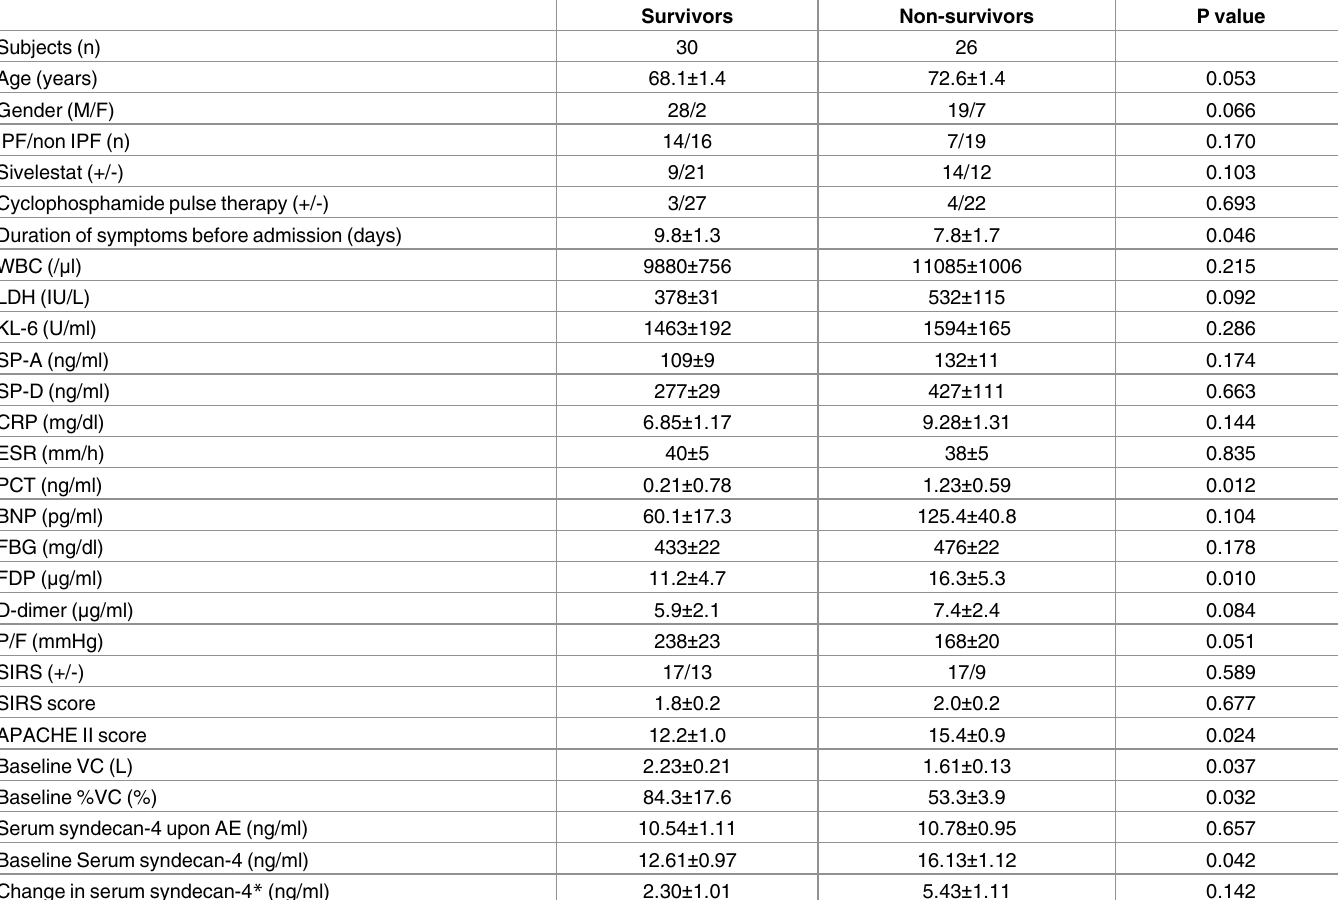
Table 4. Comparison of the clinical characteristics of survivorsand non-survivors of